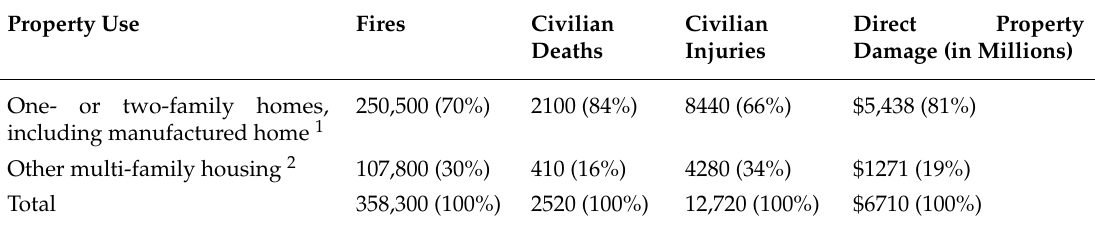
Table 2. Reported home structure fires by property use (NFPA [3]), 2010–2014 annual averages. Property Use